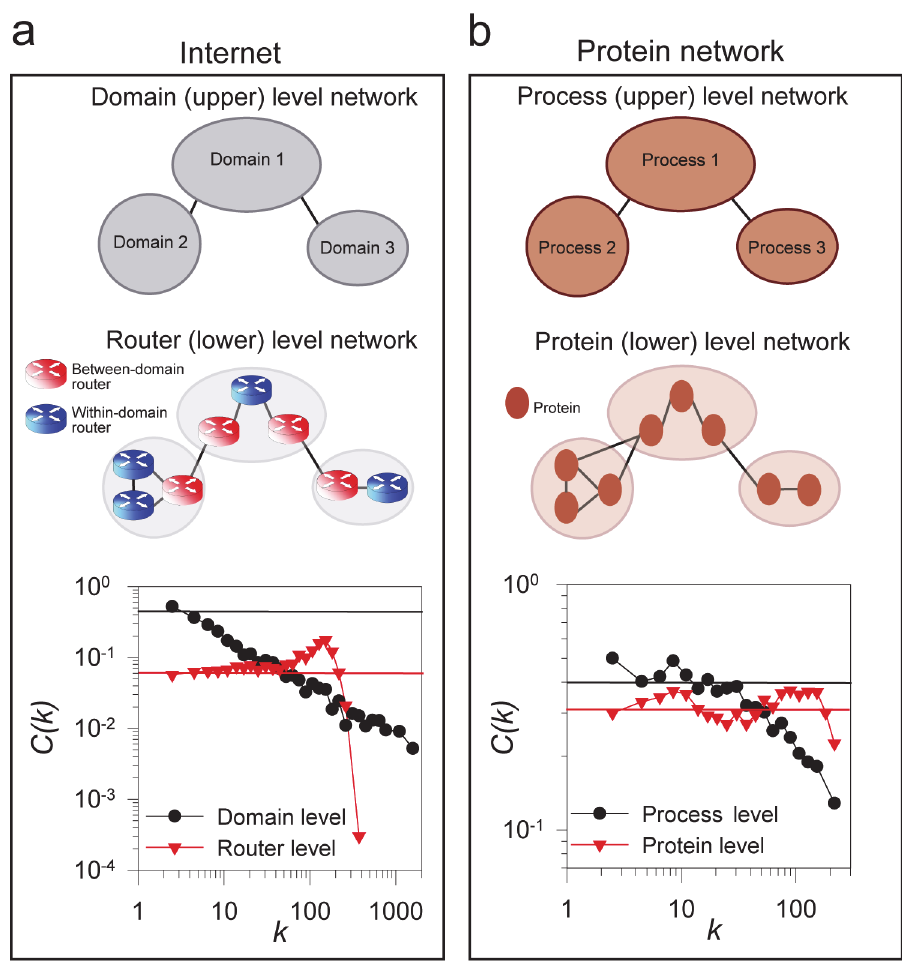
Fig 3. Dichotomy of the same entities by alternative network representations. Alternate representations of the same network can lead to different topologies, especially for networks with natural hierarchical organization. We illustrate this tendency for (a) the Internet and (b) the yeast cell proteome. Each can be modeled by networks at two different granularities, representing nodes either as upper level components (internet domains or protein processes) or lower level components (internet routers or individual proteins). For the internet, previous Internet mapping studies provide both a router-level network and a domain-level network [24]; each domain is composed on multiple routers, and domains are connected via between-domain routers. For the protein network, we defined protein processes by hierarchically clustering proteins based on their pairwise interactions as in [12]. A total of 333 biological processes were defined and connections between processes were defined based on pairwise interactions between proteins within each process. The networks ’ hierarchical structure was analyzed and plotted as in Fig. 2 , marking the mean clustering coefficient for each entire network as a horizontal solid line in the plot. The non-hierarchical router and protein networks generally exhibited clustering coefficients near this average regardless of node degree, although for the Internet router-level network, routers with > 300 connections showed exceptionally low clustering coefficients primarily due to a small number of between-domain routers located at a few top-level domains of the